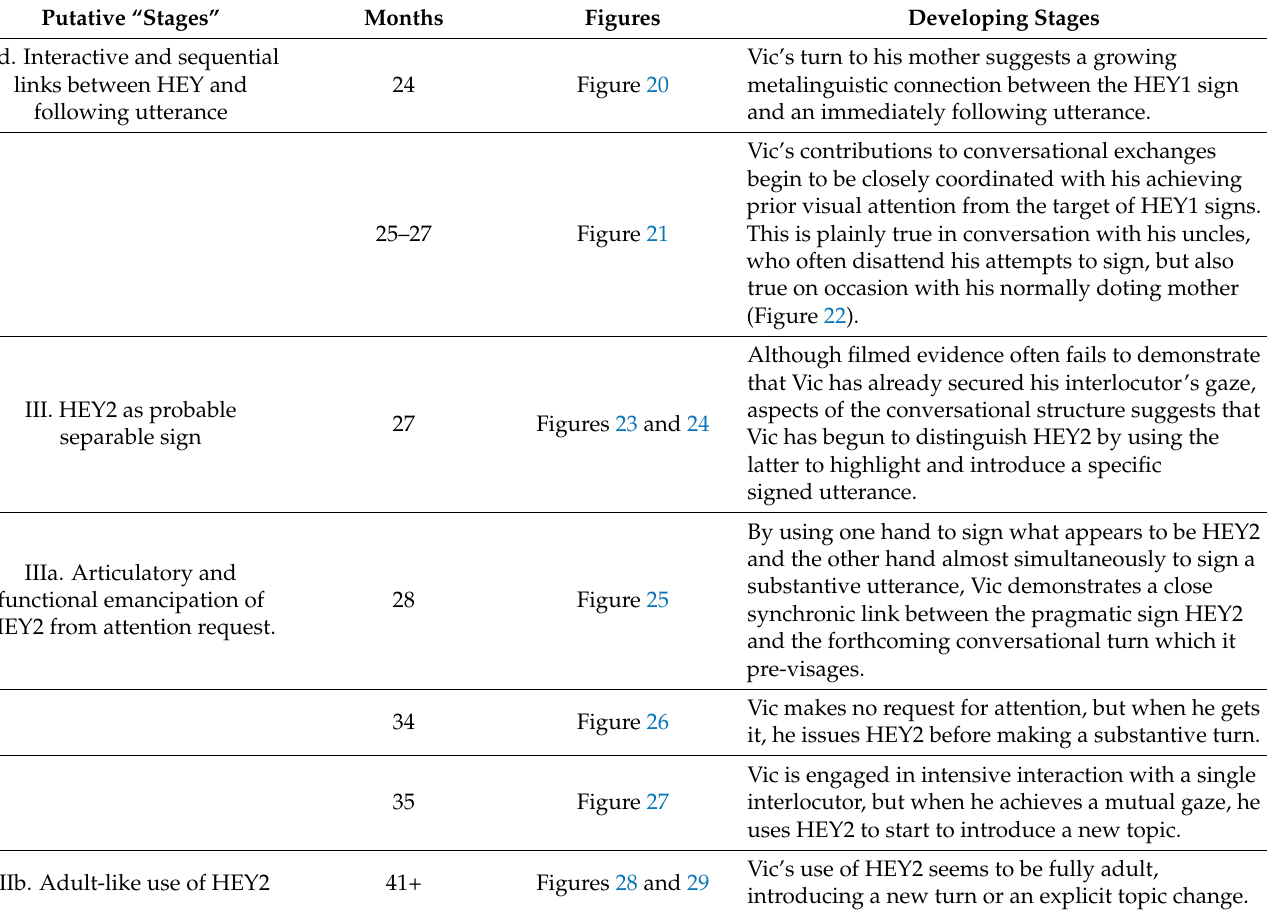
synchronic link between the pragmatic sign HEY2 and the forthcoming conversational turn which it pre-visages. Vic makes no request for attention, but when he gets it, he issues HEY2 before making a substantive turn. Vic is engaged in intensive interaction with a single Figure 27 interlocutor, but when he achieves a mutual gaze, he uses HEY2 to start to introduce a new topic. Vic’s use of HEY2 seems to be fully adult, Figures 28 and 29 introducing a new turn or an explicit topic